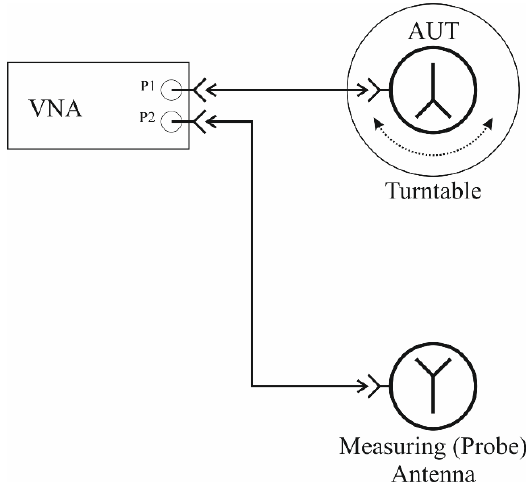
Figure 8. Far field antenna measurement diagram.